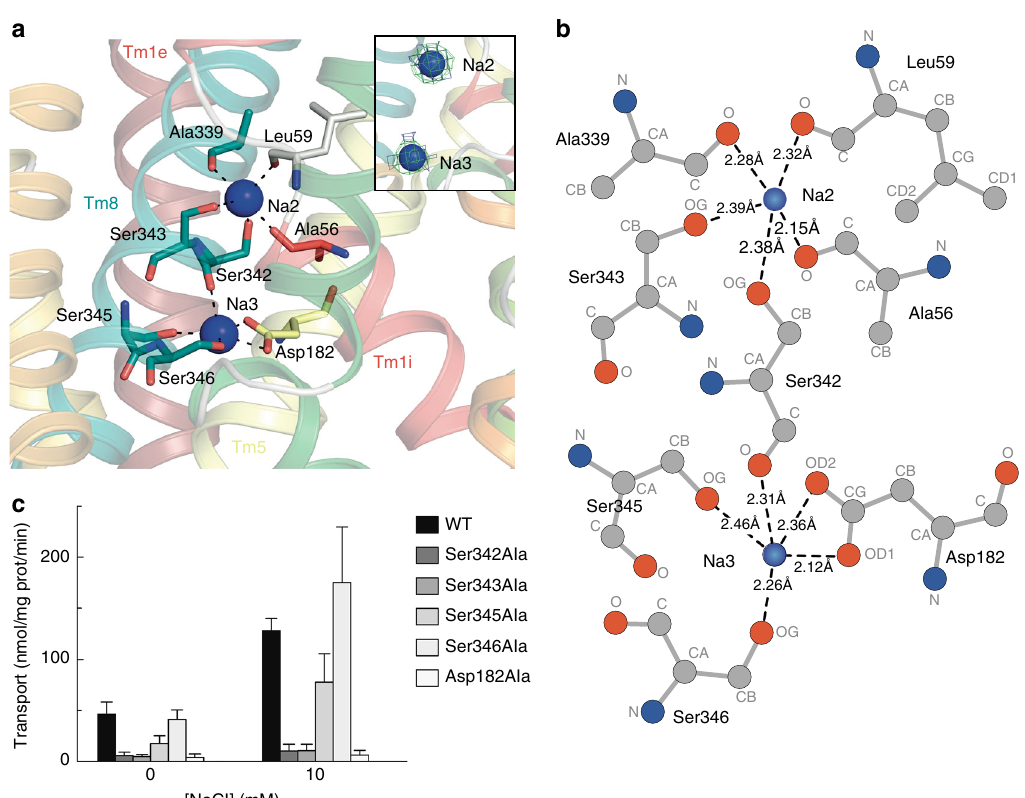
Fig. 4 The sodium-binding sites. a Amino-acid residues (sticks coloured by atom type) coordinating the two Na + ions (blue spheres). Inset depicts the omit map for the Na + ions generated by removing respective ligands from the X-ray structure followed by re fi nement. The 2 F o − F c electron density map is contoured at l σ (blue), the F o − F c map is contoured at 3 σ (green). b Ligplot + analysis of the SiaT and Na + ion interactions. Na + ion coordination is indicated by dashed lines between the atoms involved. c The kinetics of Neu5Ac transport by SiaT sodium-binding site variants. The transport of [ 3 H]-Neu5Ac with or without NaCl was measured in proteoliposomes reconstituted with wild-type SiaT and mutated variants (Ser342Ala, Ser343Ala, Ser345Ala, Ser346Ala and Asp182Ala) with an imposed K + diffusion membrane potential. Ser342Ala and Ser343Ala correspond to the Na2 site, whereas Ser345Ala, Ser346Ala and Asp182Ala correspond to the Na3 site. All proteoliposome measurements are presented as means± SD from fi ve independent